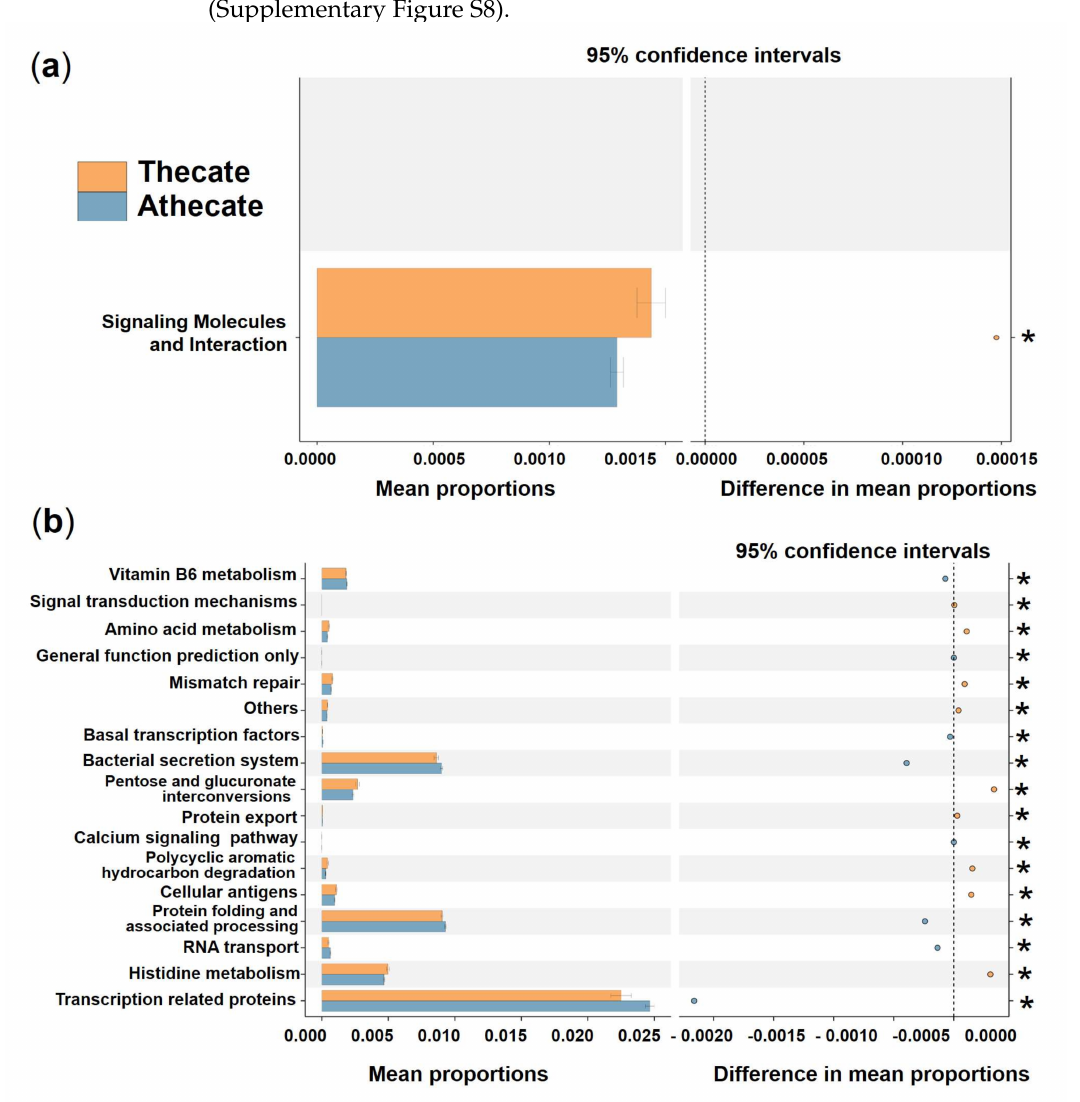
Figure 8. Prediction of the differential function of bacterial associations between the Thecate (orange) and Athecate (blue haze) groups in KEGG categories at level 2 ( a ) and level 3 ( b ). Gene functions were predicted from 16S rRNA gene-based microbial compositions using the PICRUSt algorithm to make inferences from KEGG annotated databases. Relative signal intensity was normalized by the number of the genes for each indicated metabolic pathway. * notes the difference is at a significant level with p <